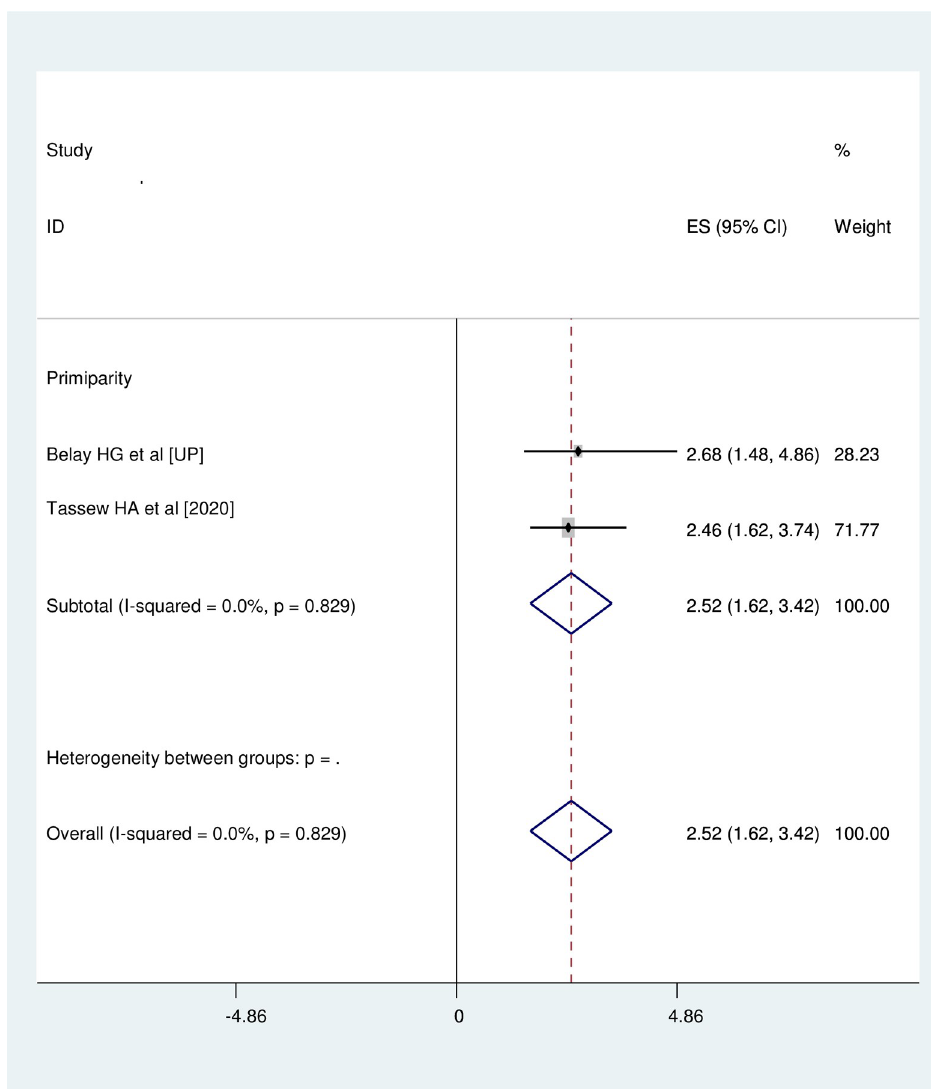
Fig 4. Association between primiparity and neonatal near